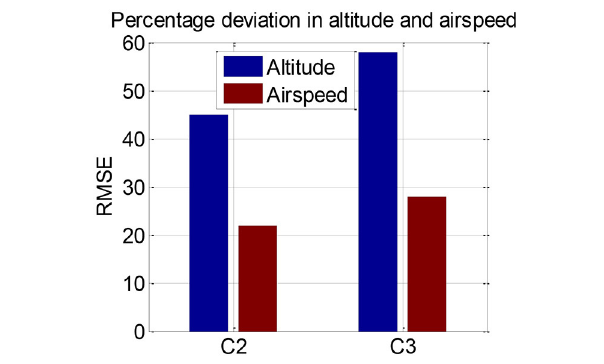
FIGURE 11 | Percentage RMSE in altitude and